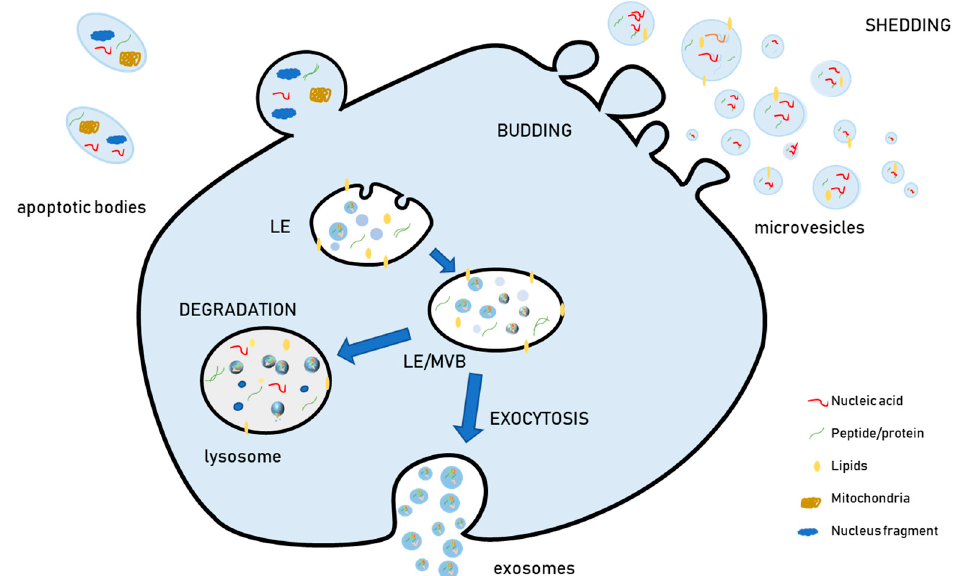
Figure 1. Schematic representation of extracellular vesicle (EV) biogenesis and release. The late endosomes (LEs) become full of small (30–120 nm) ILVs (Intraluminal Vesicles) and take the name of MVBs (Multivesicular Bodies), which can either fuse with lysosomes to degrade their cargo, or with the plasma membrane to release their cargo extracellularly (exosomes). Microvesicles originate from the outward budding of the plasma membrane and, as soon as they are produced, they are released extracellularly. Note that microvesicles are more heterogeneous in size (100–1000 nm). Apoptotic bodies are a heterogenous population of vesicles (50–500 nm) released from cells undergoing apoptosis.